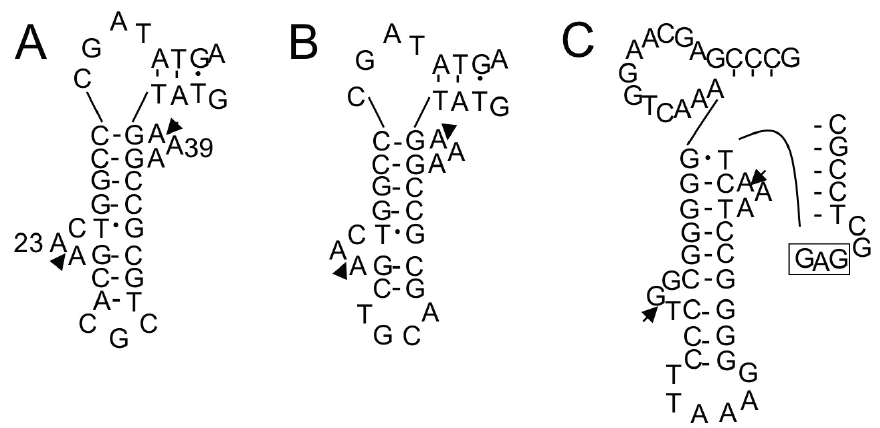
Figure 7. Exon-intron border regions of unspliced forms of tRNA Glu (UUC) ( A ); tRNA Glu (CUC) ( B ); and tRNA Leu (GAG) ( C ) of S. tokodaii strain7 [15]. These are examples of introns located at positions other than position “37/38”. In ( A , B ), only the D-arm region is shown; In ( C ), only the D-arm and anticodon arm regions are shown. The arrowheads indicate the exon-intron borders determined in our previous study